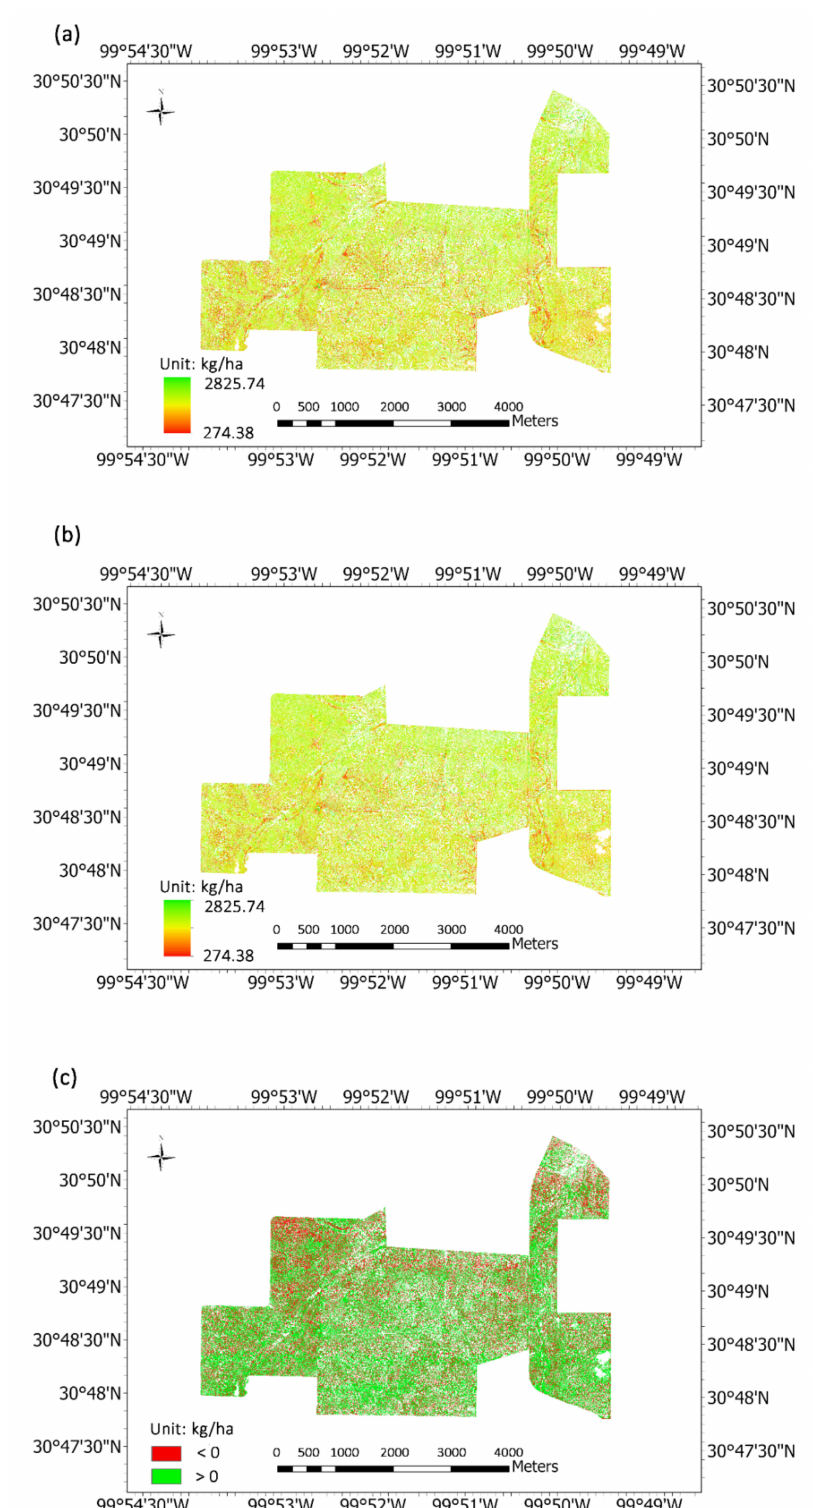
Figure 3. Biomass maps based on high spatial resolution images: ( a ) biomass map without texture indices as explanatory variables, ( b ) biomass map with texture indices as explanatory variables, and ( c ) differences between the biomass maps with and without texture indices as explanatory